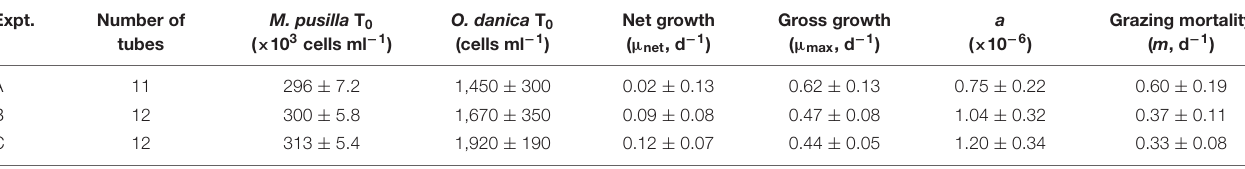
TABLE 1 | Saturation experiments using cultures of Ochromonas danica grazing on Micromonas pusilla over 24 h.